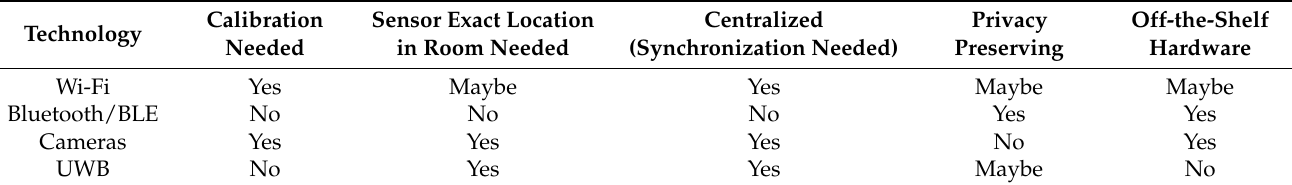
Table 4. Summary of technologies that could be used for indoor location estimation. GPS is not included as it is only effective outdoors, and IMU is not included as it only provides relative movement information if not combined with one of the following technologies. Note that ‘centralized’ refers to if the location estimation happens on a ‘server’ instead of on a mobile device itself. ‘Maybe’ indicates that in different applications of the technology it could satisfy the specific criterion or